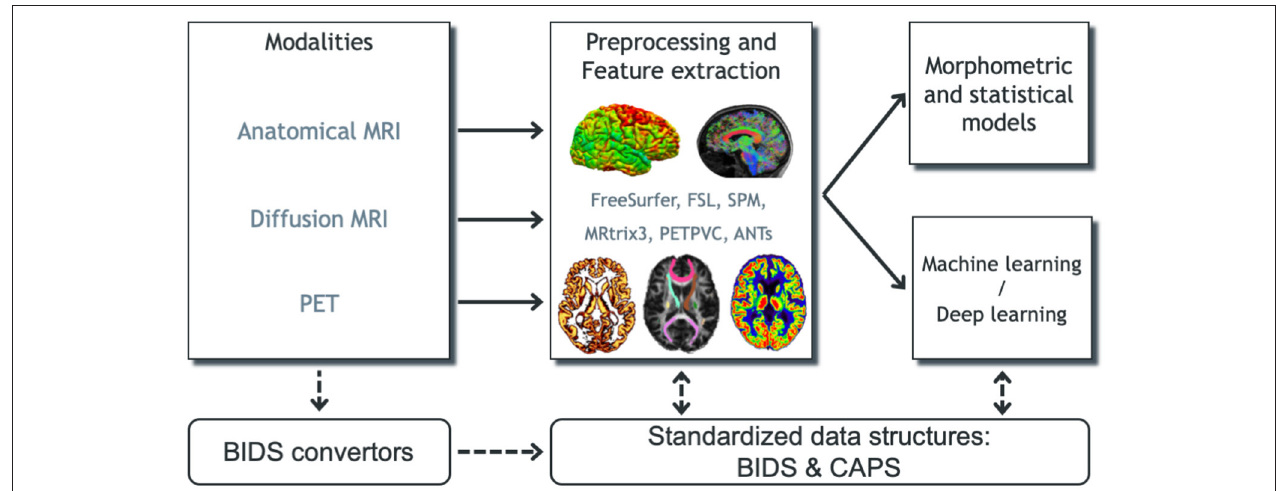
FIGURE 1 | Overview of Clinica’s functionalities. Clinica provides processing pipelines for MRI and PET images that involve the combination of different software packages, and whose outputs can be used for statistical or machine learning analysis. Clinica expects data to follow the Brain Imaging Data Structure (BIDS) and provides tools to convert public neuroimaging datasets into the BIDS format. Output data are stored using the ClinicA Processed Structure